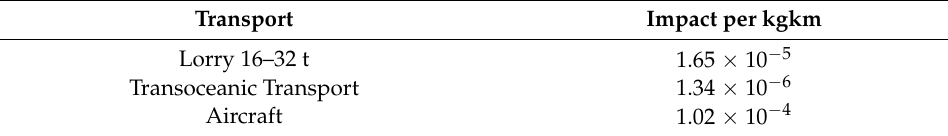
Table 6. Environmental impact of transports for the case study.